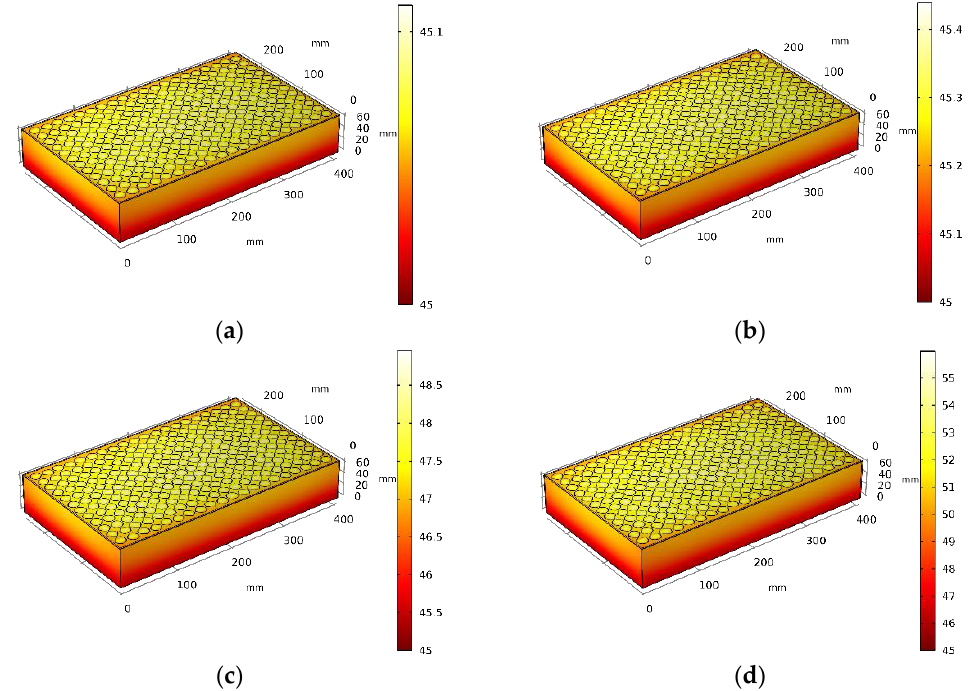
Figure 5. Temperature contours of the entire battery pack in Al housing with different C rates ( a ) 0.5C ( b ) 1C ( c ) 3C ( d ) 5C while ambient temperature of 45 ◦ C is considered. The temperature contours at 0.5C, 1C, 3C, and 5C discharge rates while operating